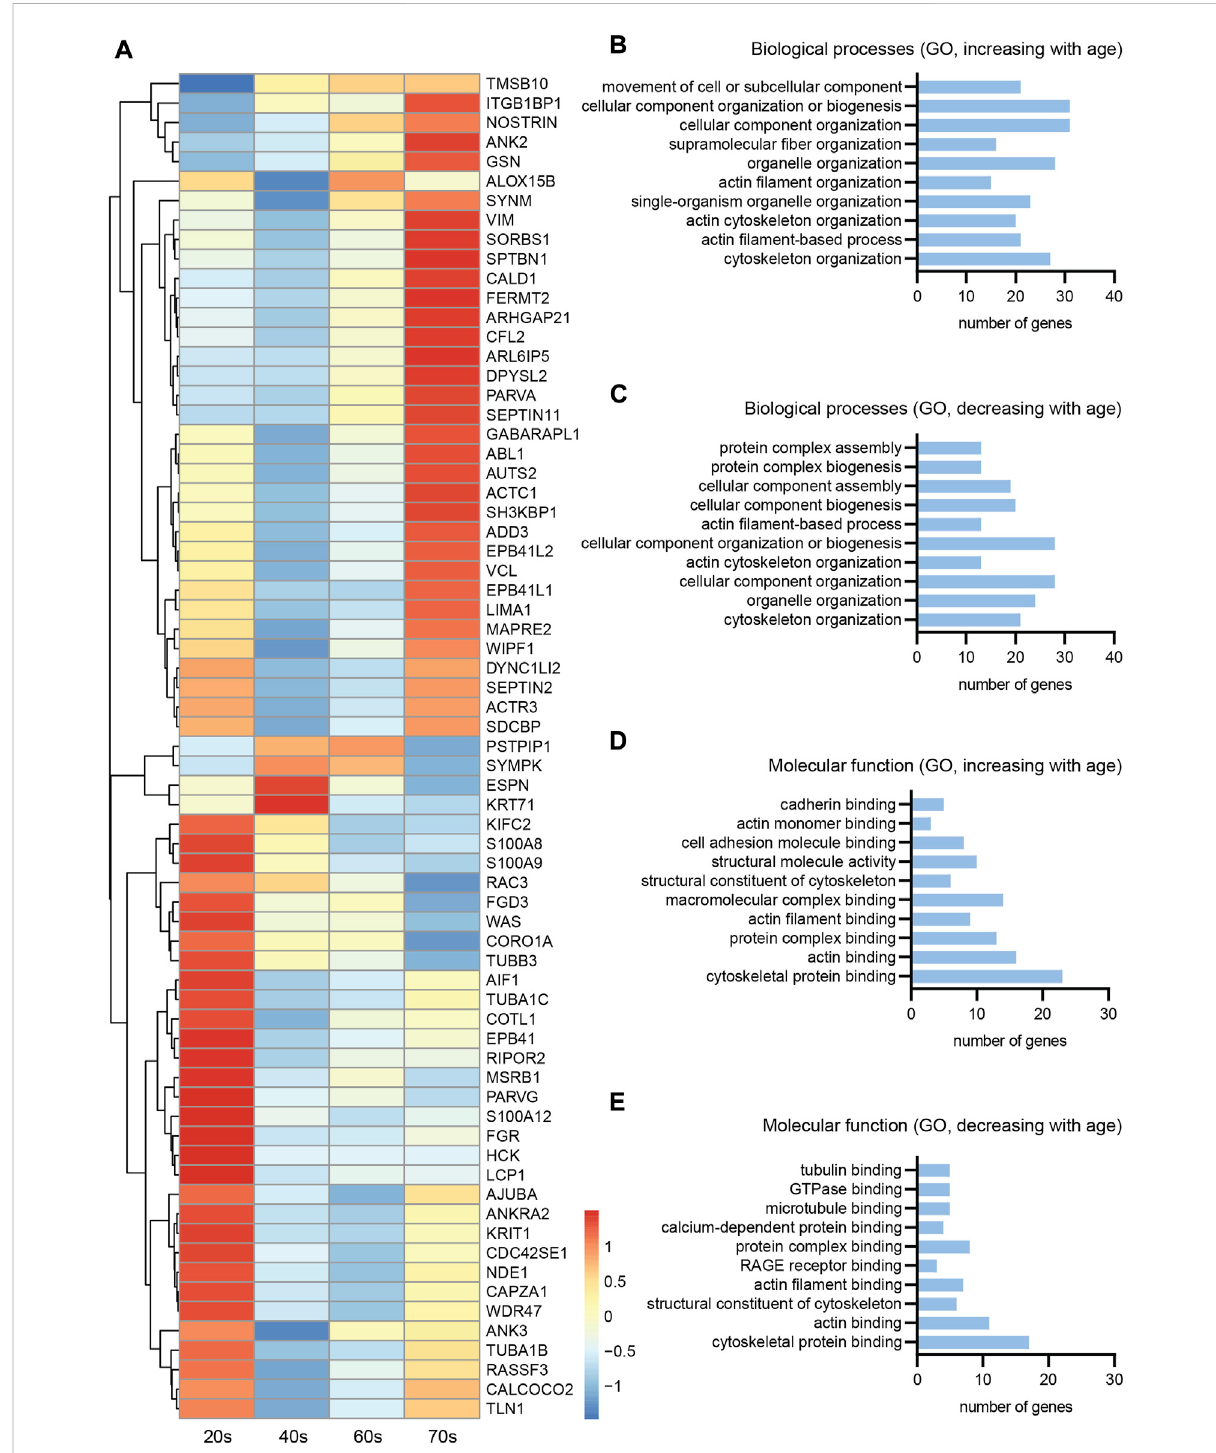
FIGURE 6 Transcriptomics of skin biopsies for cytoskeletal gene expression. (A) Normalized row-scaled expression of transcriptomic data fi ltered for differentially expressed cytoskeletal genes between the four age groups (20s, 40s, 60s, and 70s). Main expression patterns: an increase with age ( A , top),an increase towardsthe40s/60swith afollowingdecrease ( A ,middle), andadecreasingexpression withage( A ,bottom). (B – E) GeneOntology (GO) analysis for the cytoskeletal genes, divided into two groups with either increasing or decreasing expression with age, regarding both biological processes ( B , increasing; C , decreasing) and molecular function ( D , increasing; E , decreasing), revealing many of the differentially expressed cytoskeletal genes to be associated with the actin